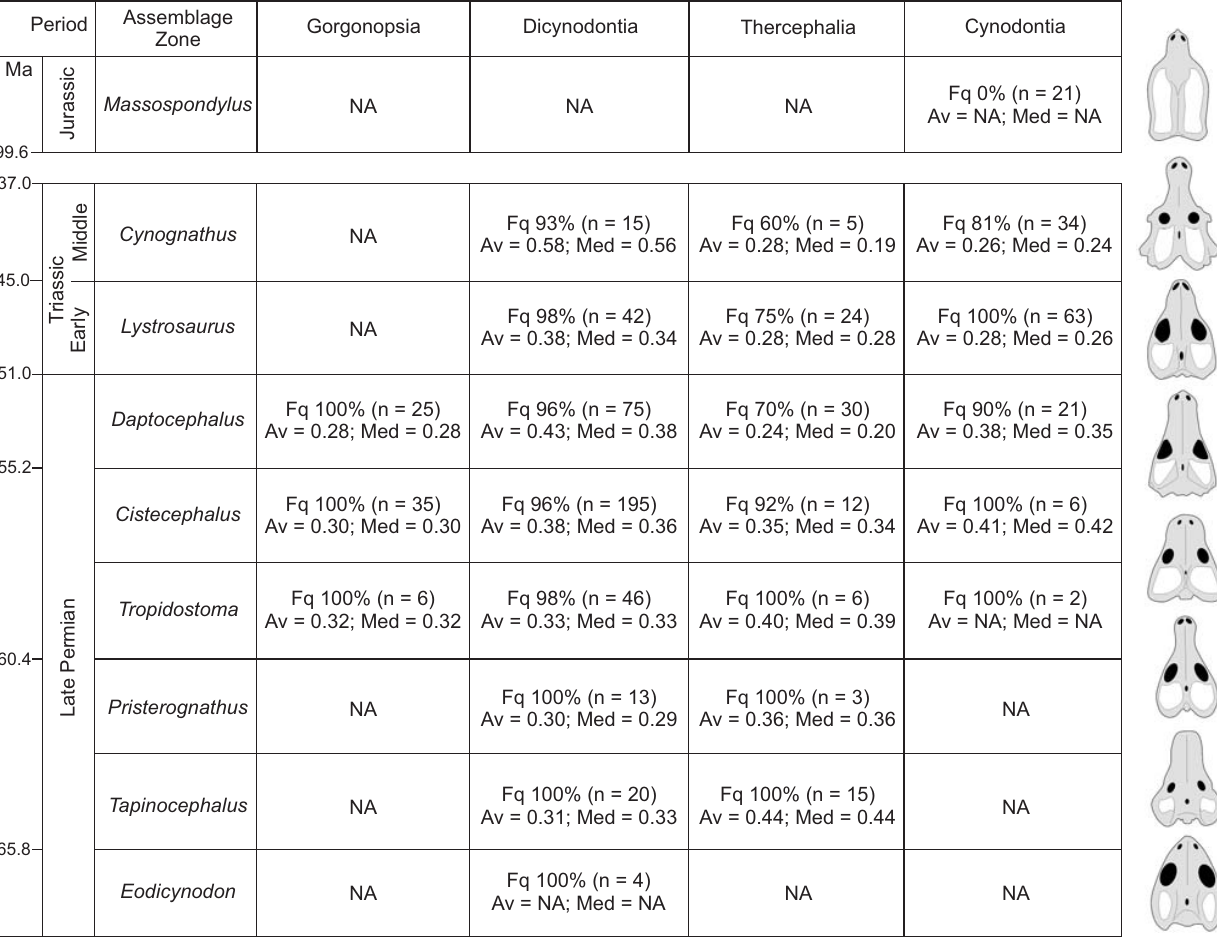
Fig. 3. Evolution of the frequency of the presence of the parietal foramen (Fq), and average (Av) and median (Med) size of the parietal foramen across geological times. Number of specimens examined (n) is indicated for each group. NA, no data available. Biostratigraphy (Assemblage Zones) and dates after Rubidge (2005) and Rubidge et al.